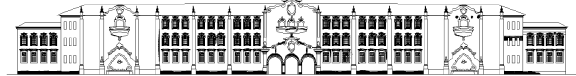
Figure 04 . CAD drawing of the main facade of P1 building (Source: Sustainable Management Center – NGS, elaborated by undergraduate students of Architectural and Urbanism bachelor of